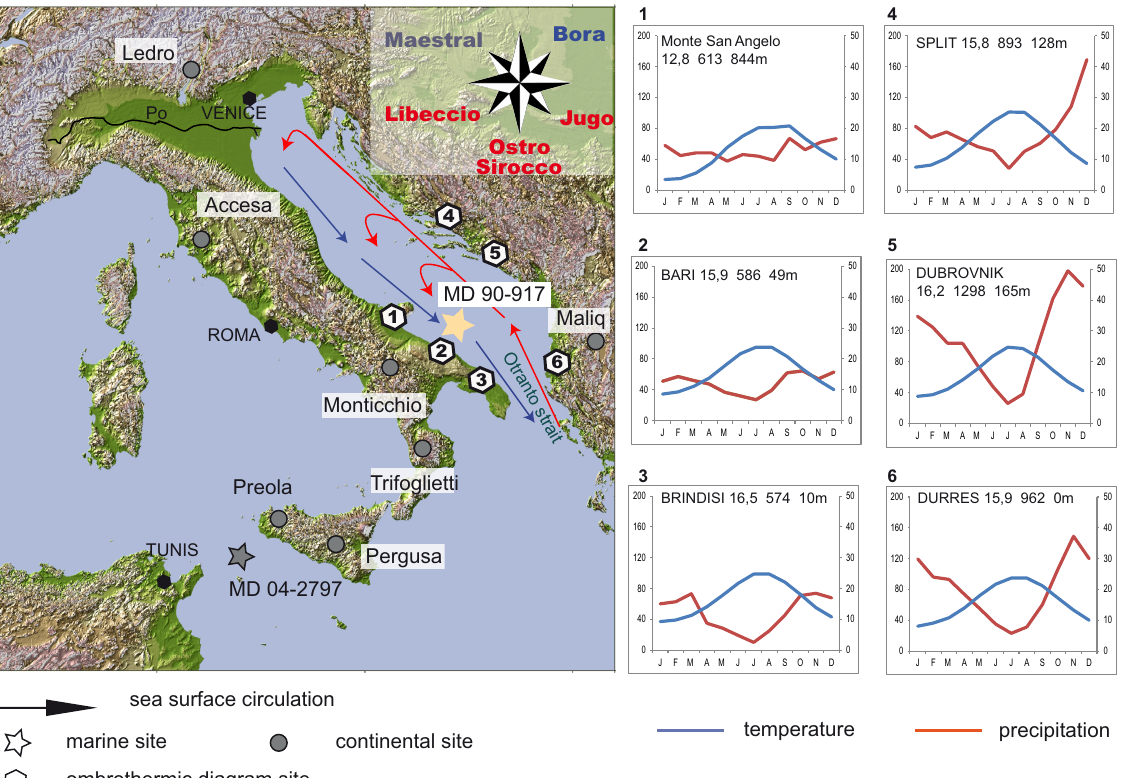
Fig. 1. Location of core MD 90-917. On the map is indicated sea surface circulation in Adriatic Sea and winds blowing over the Adriatic Basin. A selection of ombrothermic diagrams is presented on the right for the surrounding borderlands to show the climate of the studied area (Walter et al., 1975; New et al., 2000, New LoCCllim software). For each ombrothermic diagram, near or below the site name is noted the annual mean temperature, the total annual precipitation and the altitude of the site. For each ombrothermic diagram, the left axis corresponds to precipitation values and the right axis to the temperature value. Red arrows represent the south–north sea surface water inflow; blue arrows draw the north–south sea surface